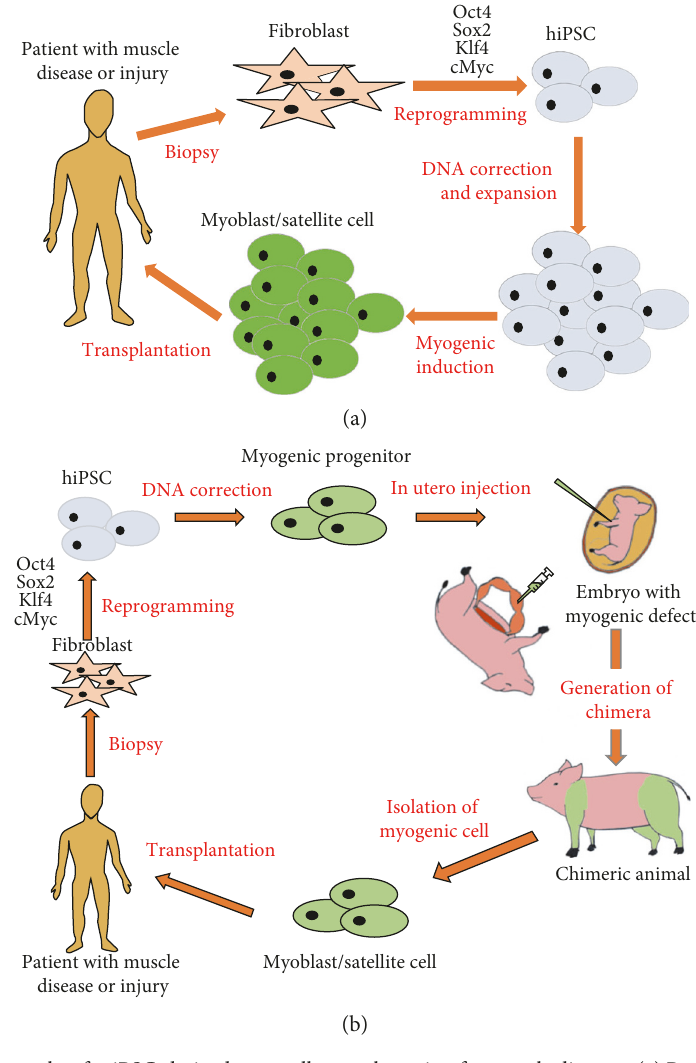
Figure 1: Current and new approaches for iPSC-derived stem cell transplantation for muscle diseases. (a) Patient-derived skin fi broblasts will be reprogramed into iPSCs by reprogramming factors. Patient-derived iPSCs will be used for DNA correction of dystrophin mutation by DNA-editing technologies. These corrected iPSCs will be induced to myogenic di ff erentiation to generate myogenic progenitor cells which will be used for autologous cell therapy for patients su ff ering from muscle diseases and traumatic muscle injury and loss. (b) Patient- derived skin fi broblasts will be reprogramed into iPSCs by reprogramming factors. Patient-derived iPSCs will be used for DNA correction of dystrophin mutation by DNA-editing technologies. These corrected iPSCs will be used for myogenic progenitor cell induction followed by in utero injection into animal embryos carrying a defect of myogenic master genes such as MyoD , Myf5 , and MRF4 , allowing chimeric animal to develop human skeletal muscle. Chimeric animal-derived patient-speci fi c myoblasts or satellite cells will be used for autologous cell therapy for muscle diseases and traumatic muscle injury and